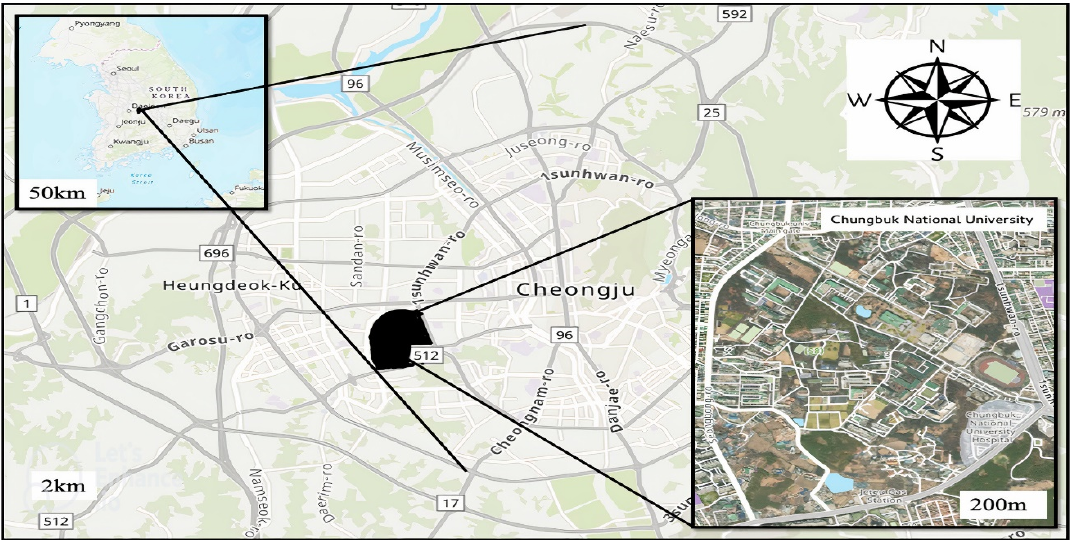
Figure 1. The location map of the sampling sites. Chungbuk National University, Cheongju City, Korea. Table 1. List of landscaping plants analyzed in this study.